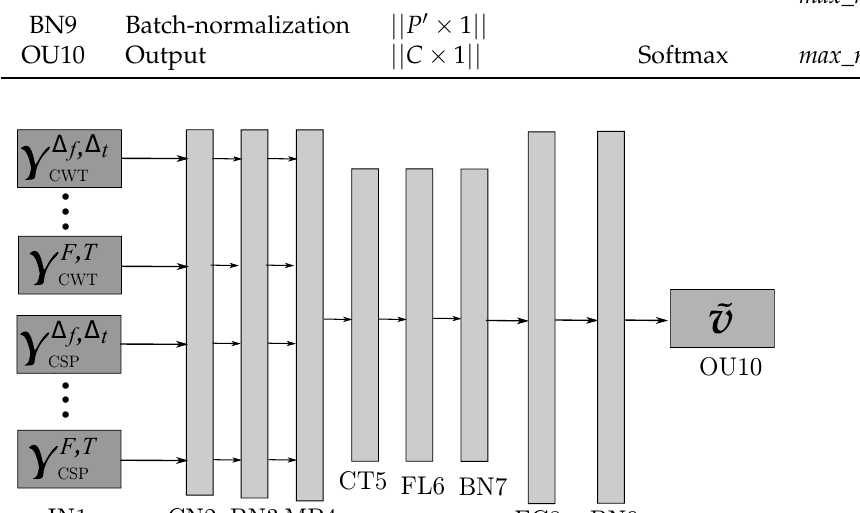
Figure 2. Scheme of the proposed Deep&Wide neural network architecture to support MI discrimination.